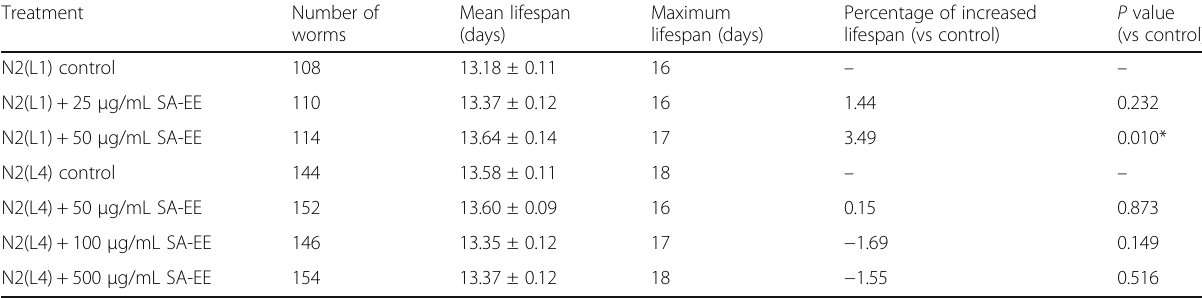
Table 2 Results and statistical analyses of SA-EE treated C. elegans lifespan assay Treatment Number of